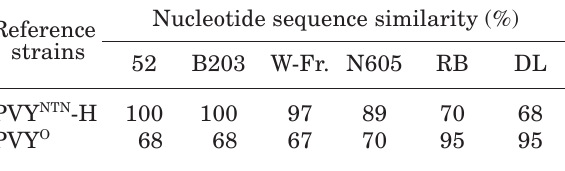
Table 1. Percent of nucleotide sequence similarity. The nucleotide sequences (500 nt long) of PCR products of isolates 52, B203, W-Fr., N605, RB and DL (determined as described in the legend to Fig. 1) were aligned with the reference sequences of PVY NTN -H and PVY O and the percent similarity was